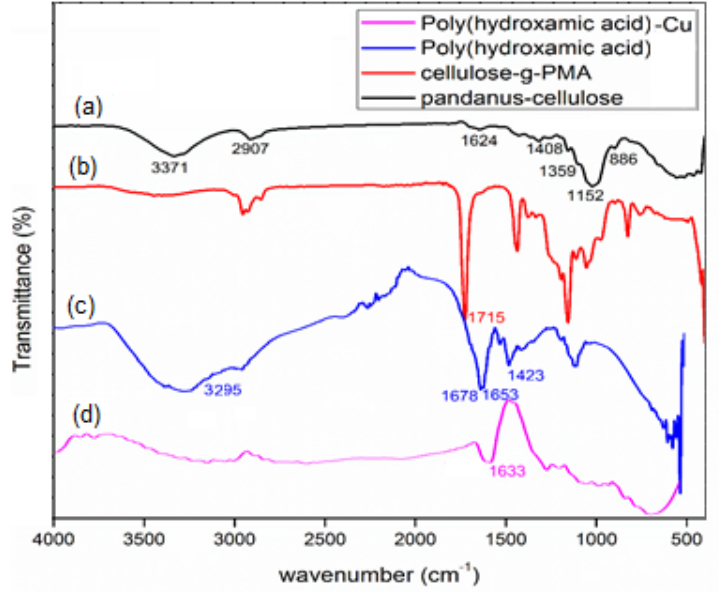
Figure 2. FT-IR spectra of ( a ) waste cellulose, ( b ) poly(methyl acrylate)-grafted cellulose ( c ) poly(hydroxamic acid), and ( d ) poly(hydroxamic acid)-copper complex. The blue-colored spectrum is representing the poly(hydroxamic acid) ligand (Figure